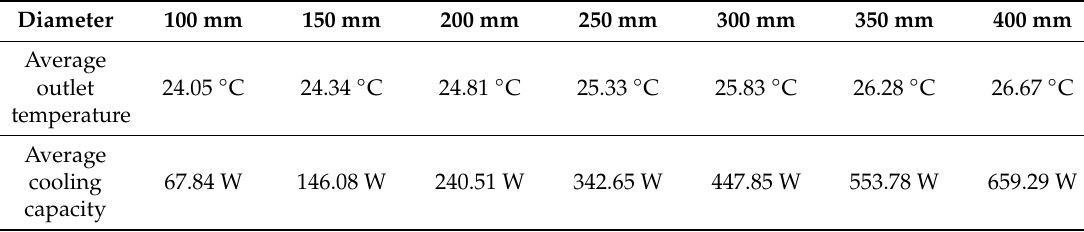
Table 4. The average outlet temperatures and cooling capacities.